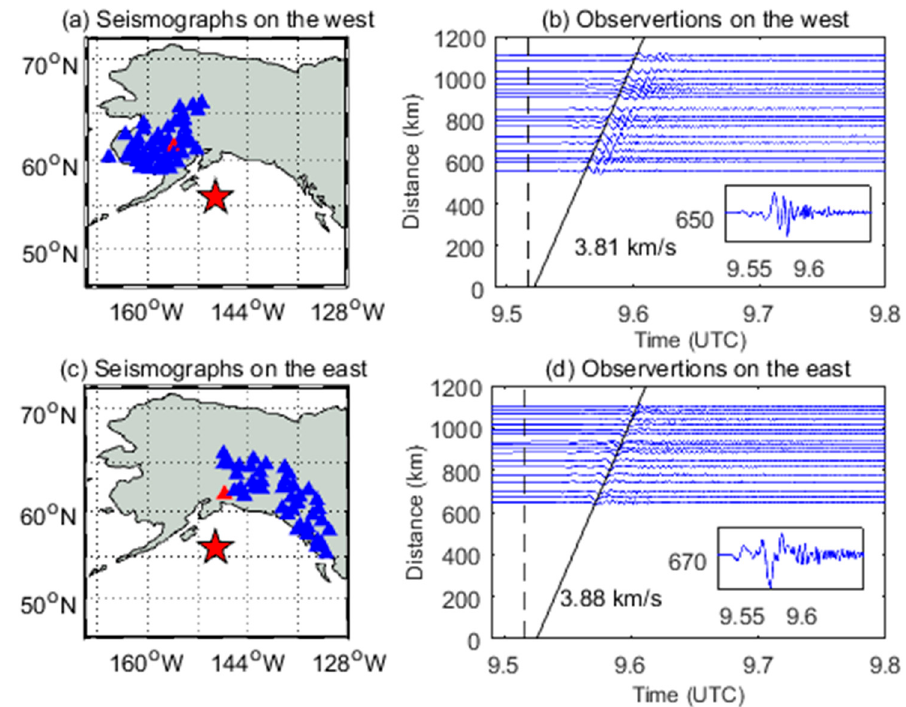
Figure 11. The vertical ground motions from the observations of 91 broadband seismographers. The location of the stations in the east and west directions of epicenter are shown in ( a , c ). The vertical components in the east and west directions are shown in ( b , d ). The sub-graphs in the ( b , d ) show the enlarged views of two stations at 650 km and 670 km from epicenter respectively and the location of two stations are shown in the ( a , c ) with red triangles.